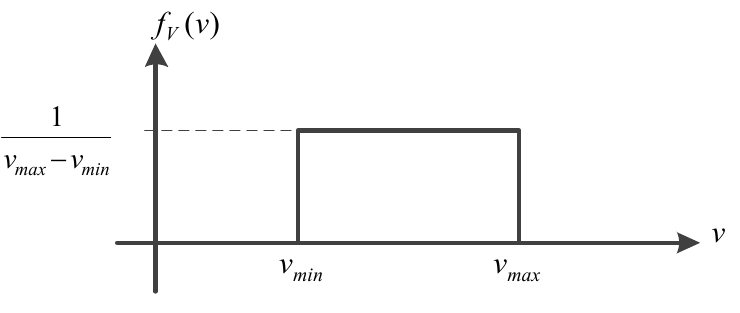
Figure A1. The density function of the random variable v